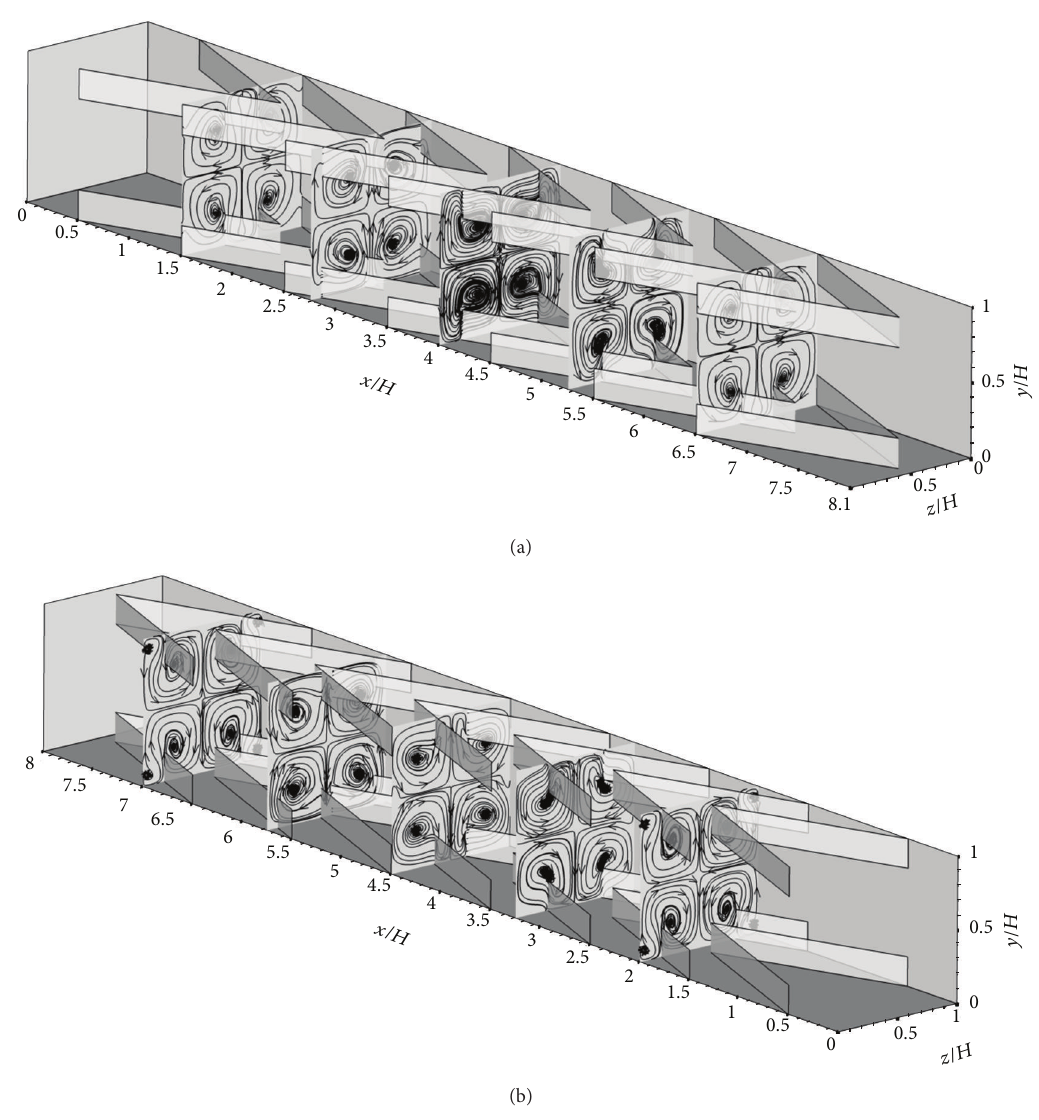
Figure 3: Streamlines in transverse planes for (a) V-Downstream and (b) V-Upstream of 20 ∘ V-rib at Re = 800 , BR = 0.20 , and PR = 1 .